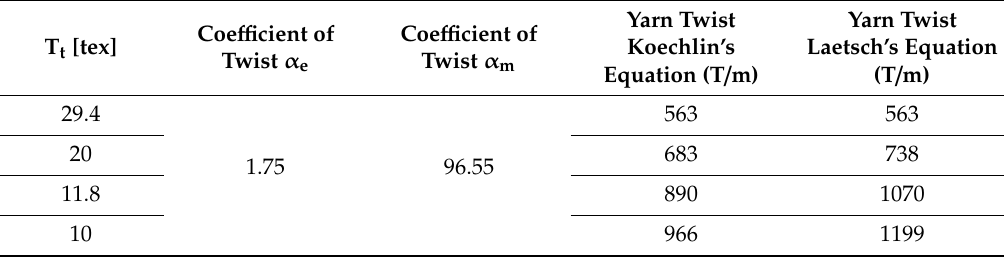
Table 3. Calculation of the number of turns per meter in